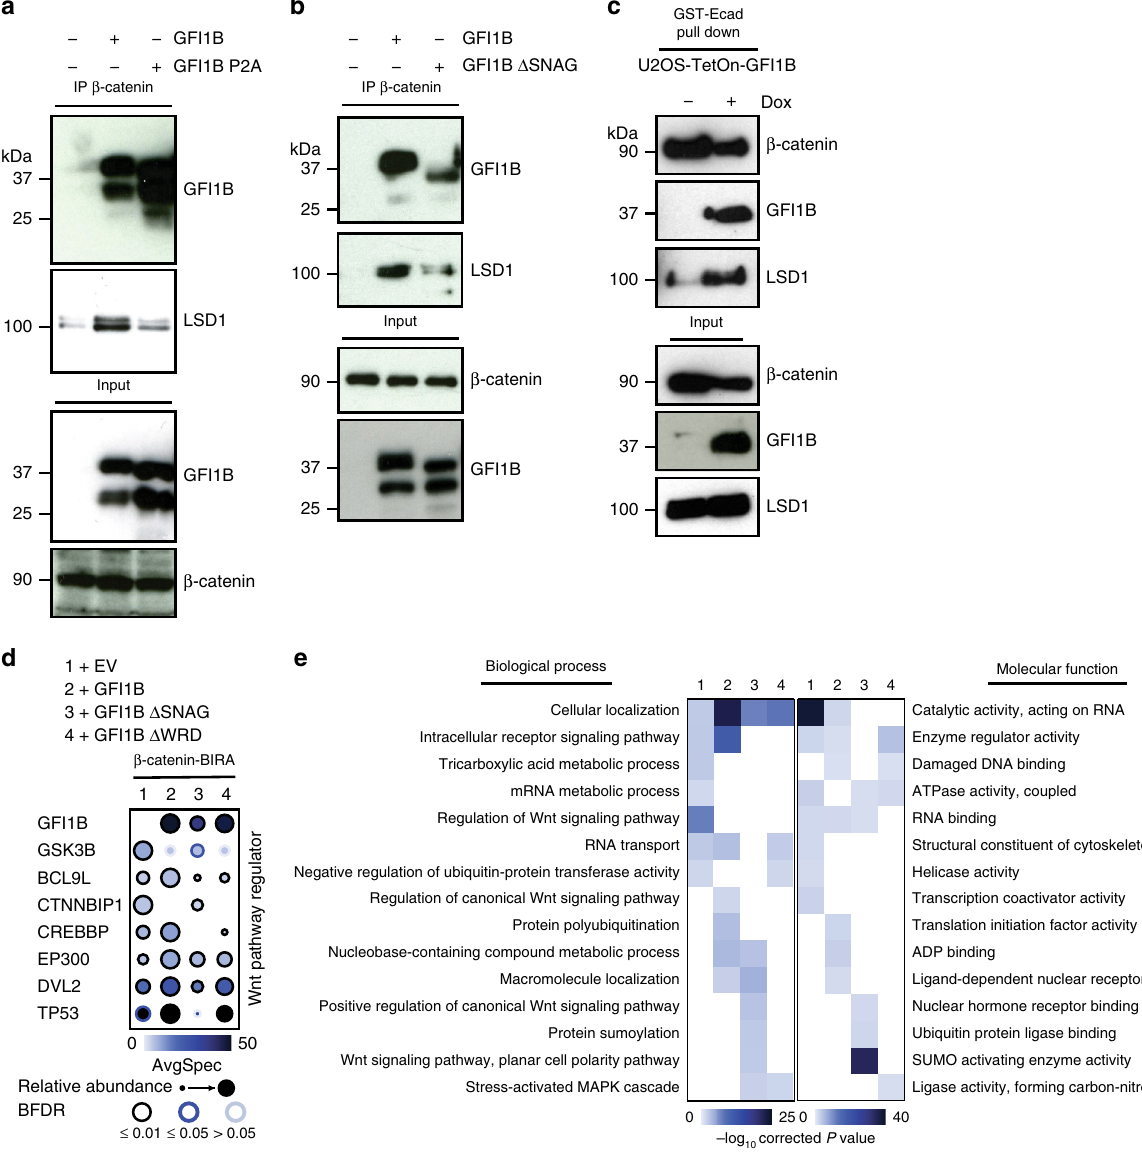
Fig. 3 GFI1B recruits LSD1 to β -Catenin containing complexes. a , b Western blot analysis of indicated proteins after immune precipitation of endogenous β -catenin from 293T cells transfected with the indicated GFI1B constructs. c GST-E-Cadherin pull down of endogenous β -catenin in U2OS cells expressing inducible GFI1B (Tet-ON system) followed by Western blot analysis. d Dot Plot showing BioID interactions of β -catenin-BirA*-Flag coexpressing an Empty Vector (1), the wild-type form of GFI1B (2), GFI1B lacking the SNAG domain (3) or GFI1B lacking the WRD domain (4) with the indicated Wnt pathway regulators in Flp-In T-REx HEK293 cells. e Heat map illustrating biological processes and molecular functions of associated GO terms. The enrichment score of each GO term is shown as the − log10 of corrected P values, indicated by different color